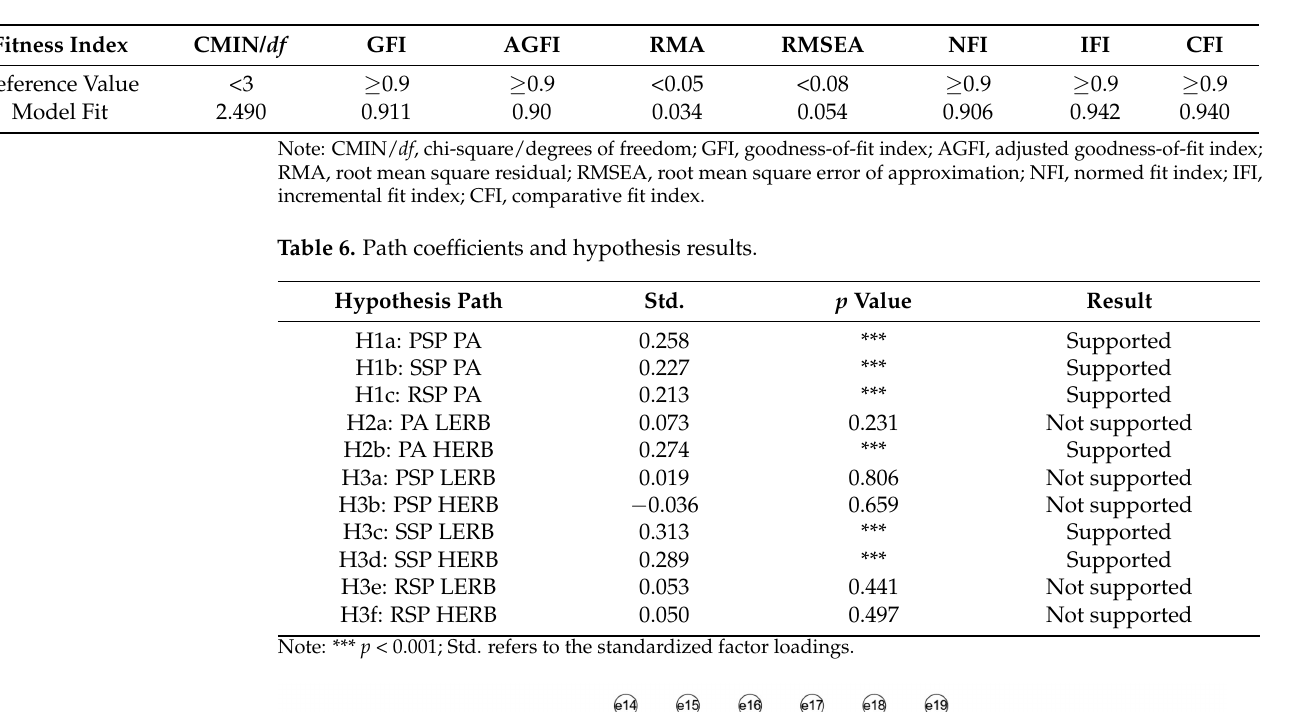
Table 5. Goodness-of-fit test for the structural model.